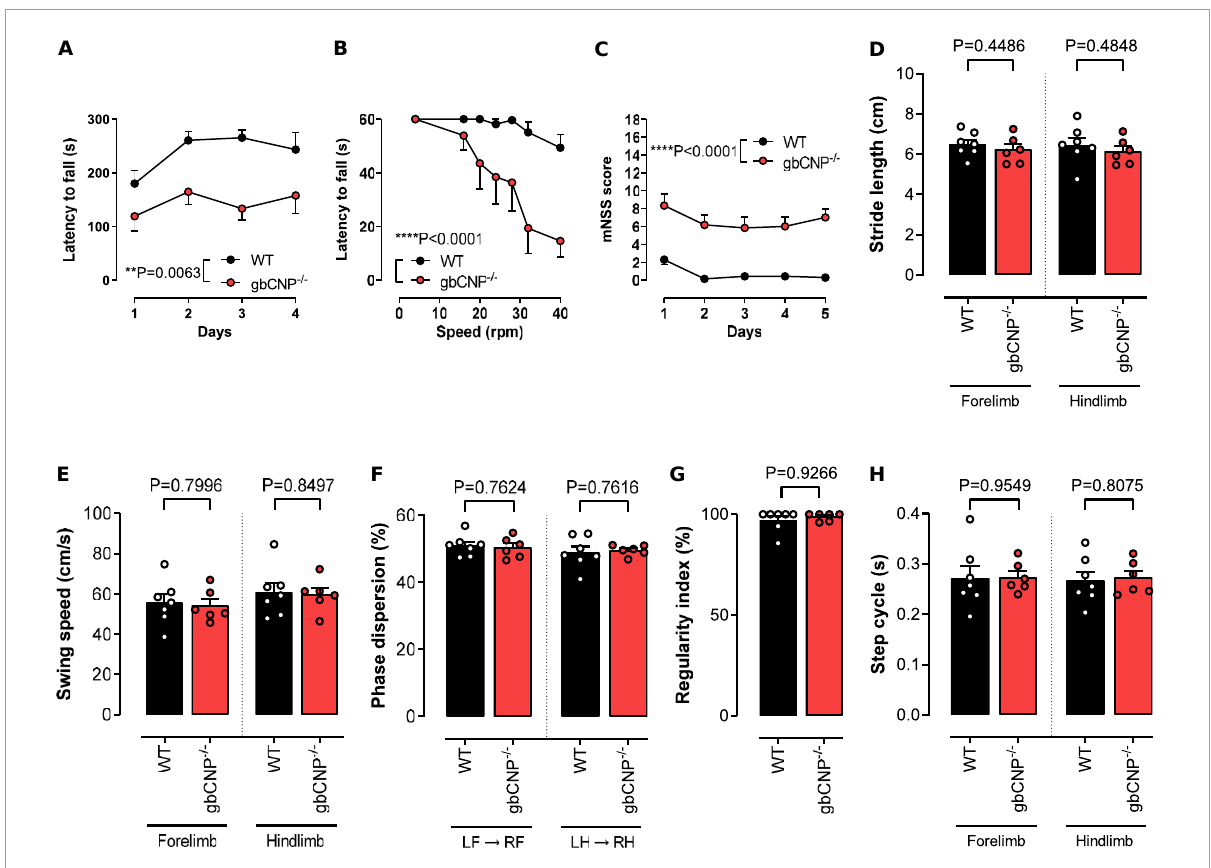
FIGURE2 Young adult gbCNP - / - mice showed normal gait and motor coordination when walking overground but not when their balance was challenged. Rotarod latency to fall when performing in accelerating (A) and fixed speed (B) modes. Modified neurological severity score ( mNSS, C) . CatWalk TM analysis of gait and coordination in wild-type (WT) and global CNP knockout (gbCNP - / - ) mice. Stride length (D) , Swing speed (E) , Phase dispersion (F) , Regularity index (G) and Step cycle (H) . n = 6-7. Statistical analysis by two-tailed Student’s t -test, Mann–Whitney U test or two-way analysis of variance with Šídák post hoc test. Each statistical comparison undertaken has an assigned P value (adjusted for